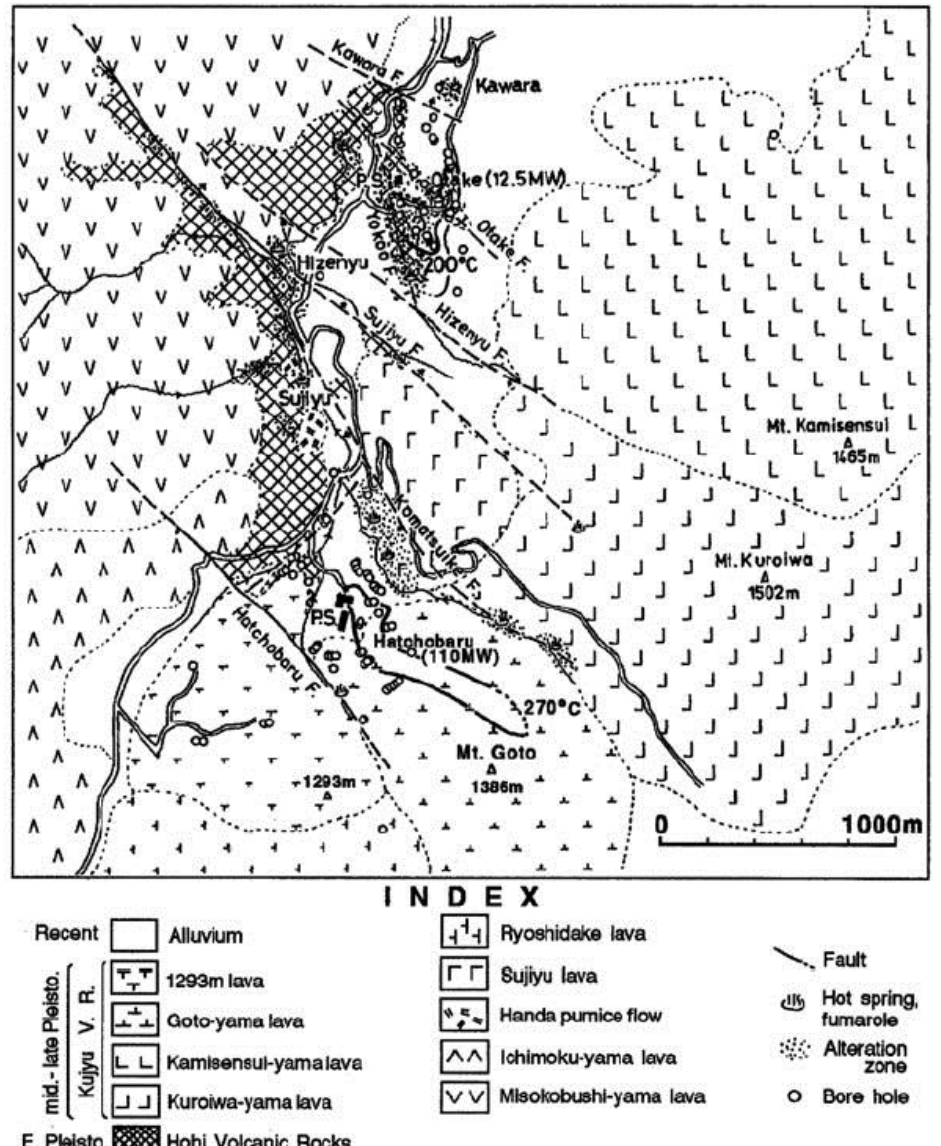
Figure 2. Geologic map of the Otake–Hatchobaru geothermal area (modified after the literature [24]). Crosshatched area = early Pleistocene Hohi volcanic rocks; others = middle–late Pleistocene Kujyu volcanic rocks.